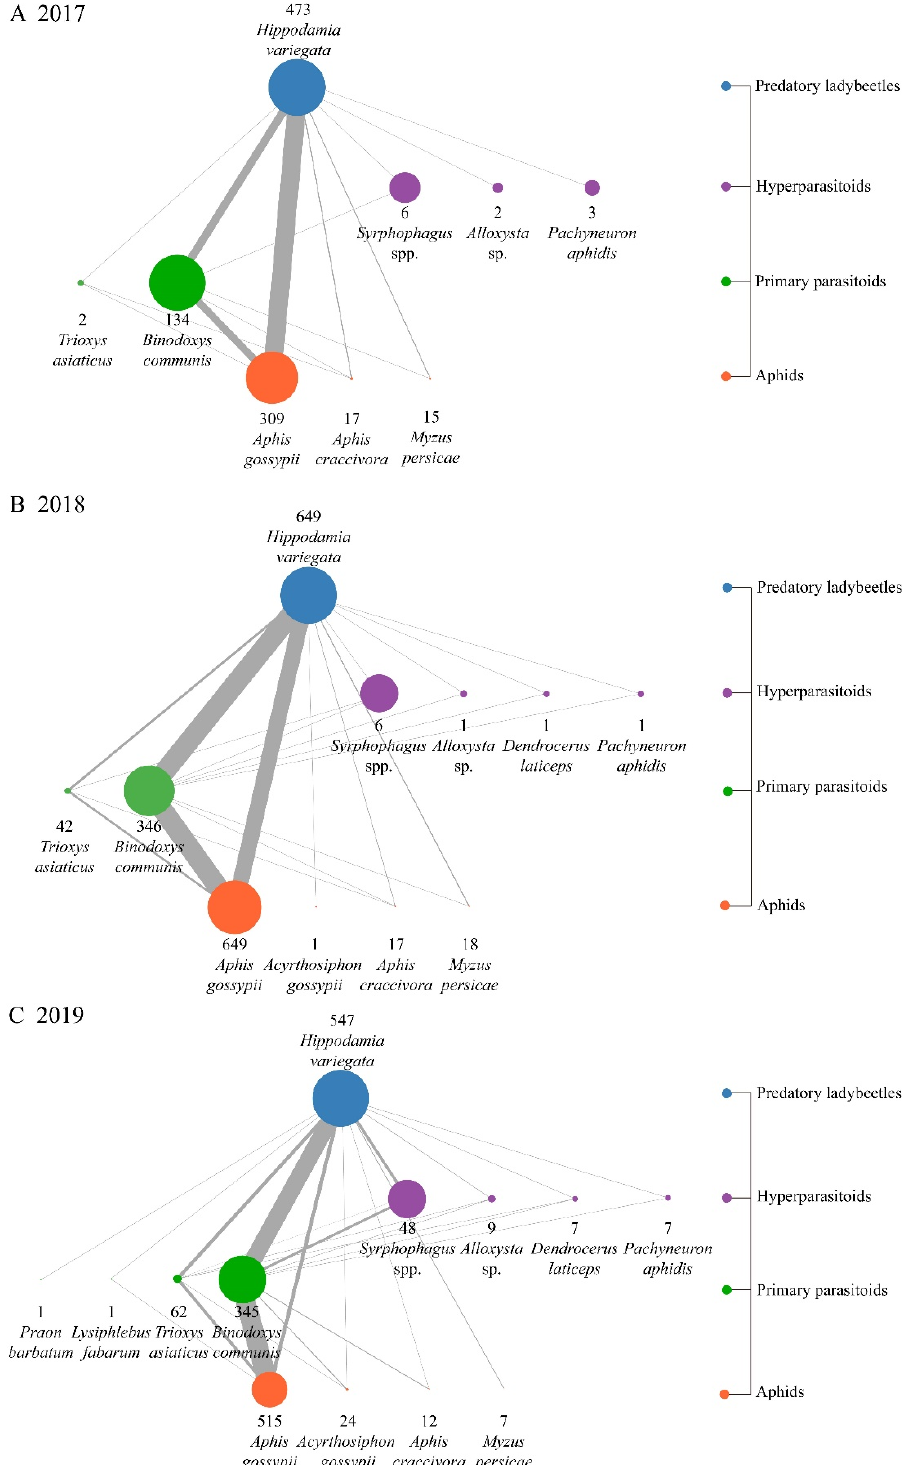
Figure 4. Quantitative food webs of aphids, primary parasitoids, hyperparasitoids and Hippodamia variegata in cotton fields. Each circle represents a species; the number below the circle is the detection frequency of the species, and the size of the circle represents the relative abundance of the species at the same trophic level. The width of the connecting lines represents the relative number of higher trophic species attacking the lower trophic species.